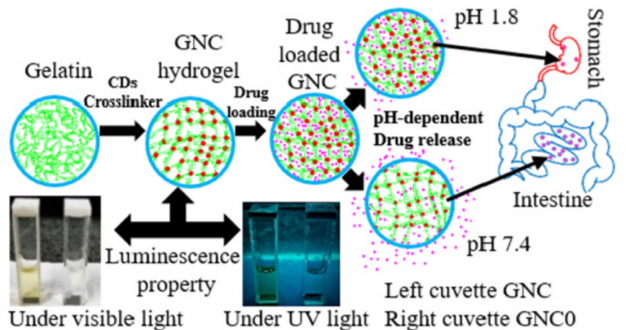
Figure 5. Formation of the gelatin nanocomposite crosslinked with carbon dots and loaded with a drug that is released in the gastrointestinal tract. The gelatin nanocomposite (GNC) hydrogels show fluorescence properties for biosensing and measuring the pH of the digestive system. Reprinted with permission from reference [88]. Copyright 2020 American Chemical